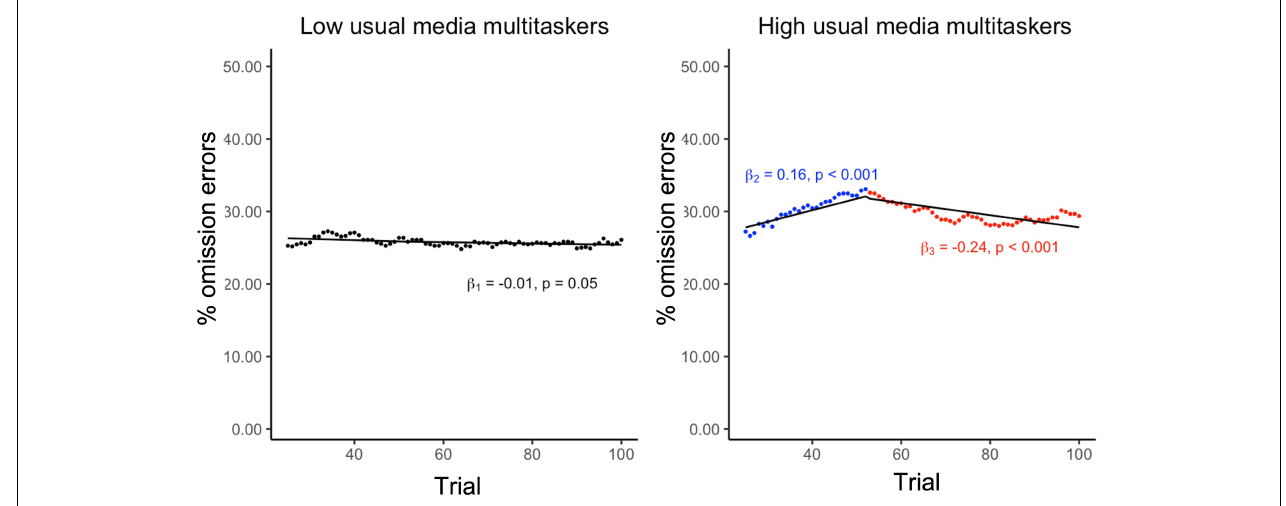
FIGURE 1 | Sustained attention task performance presented as the 25-trial omission error rate by usual media multitasking dichotomized at the median. Regression lines plotted over the raw values. β 1: For the sustained attention condition data, β from a mixed effect linear regression, nested within participant, for trial number predicting the 25-trial moving average among low usual media multitaskers. β 2 and β 3 : For the sustained attention condition data, β s from a mixed effect spline regression, specifying a single knot and nested within participant, predicting the 25-trial moving average among high usual media multitaskers.